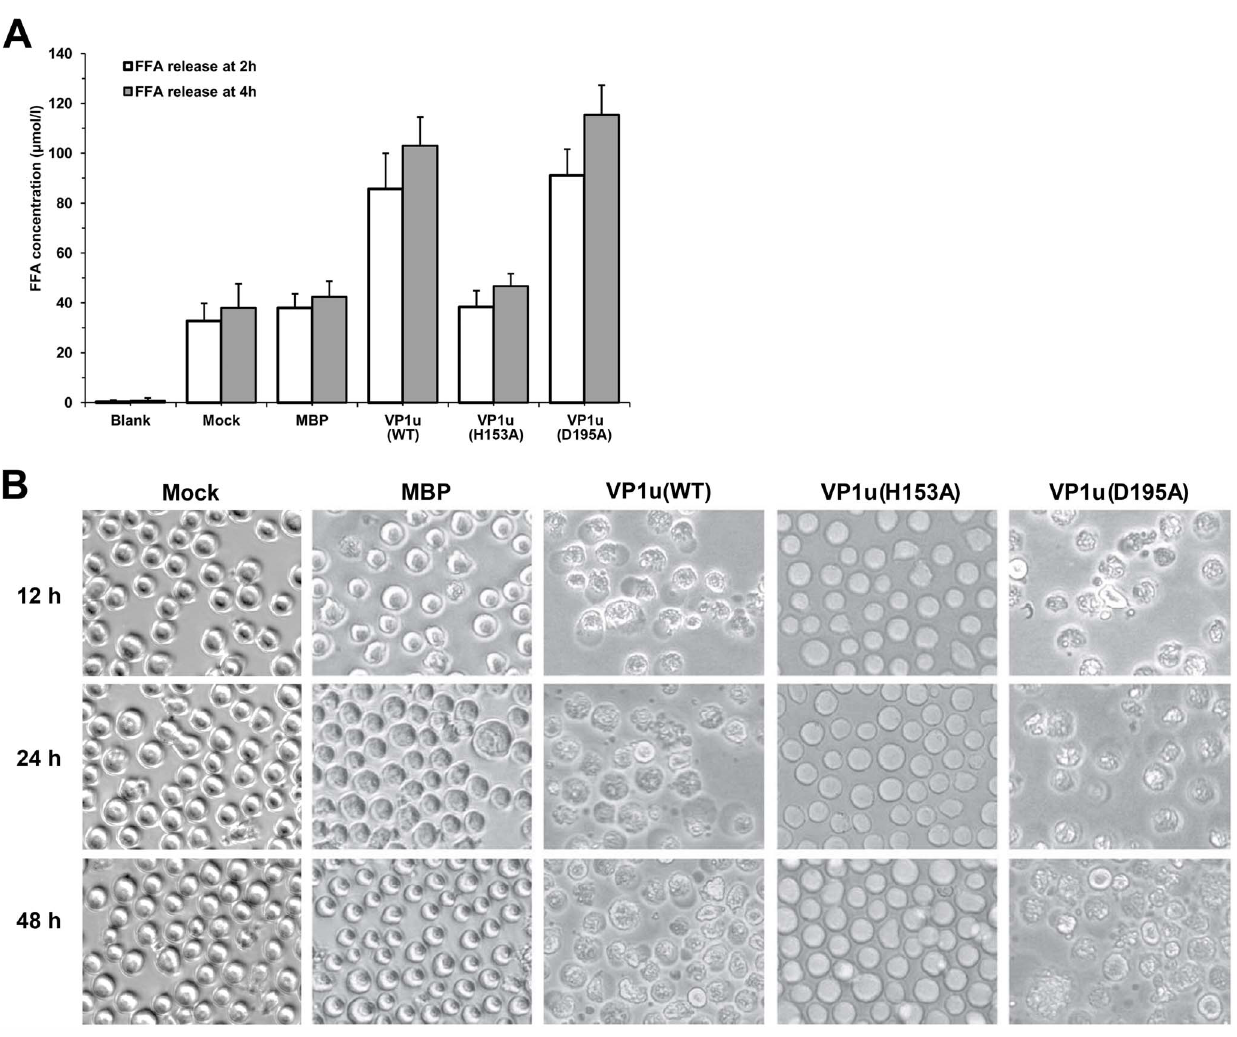
Figure 4. Effect of viral PLA2 on the morphology of UT/7-Epo cells. (A) Release of free fatty acid from UT7-Epo cells. Cells were treated for 2 h or 4 h with the different mutated VP1u proteins. Blank: RPMI-1640 medium; Mock: UT7-Epo cells without protein treatment; MBP, VP1u, VP1u(H153A), or VP1u(D195A): UT7-Epo cells were treated with purified MBP, VP1u, VP1u(H153A) or VP1u(D195A) proteins. Data are representative of three independent experiments. (B) Cell morphological observation after treatment with various proteins. Mock: normal UT7-Epo cells without protein treatment; MBP, VP1u(WT), VP1u(H153A), and VP1u(D195A): cells were treated with MBP, VP1u(WT), VP1u(H153A) and VP1u(D195A) proteins, respectively, for 12 h, 24 h or 48 h. Images were taken at a magnification of 6 20 (objective